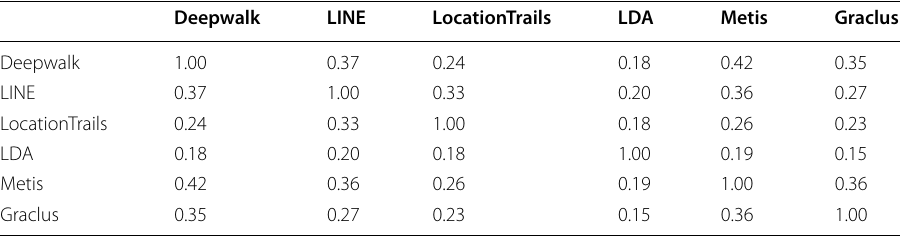
Table 3 Normalized mutual information between communities identified by methods on black- dominated neighborhoods Deepwalk LINE